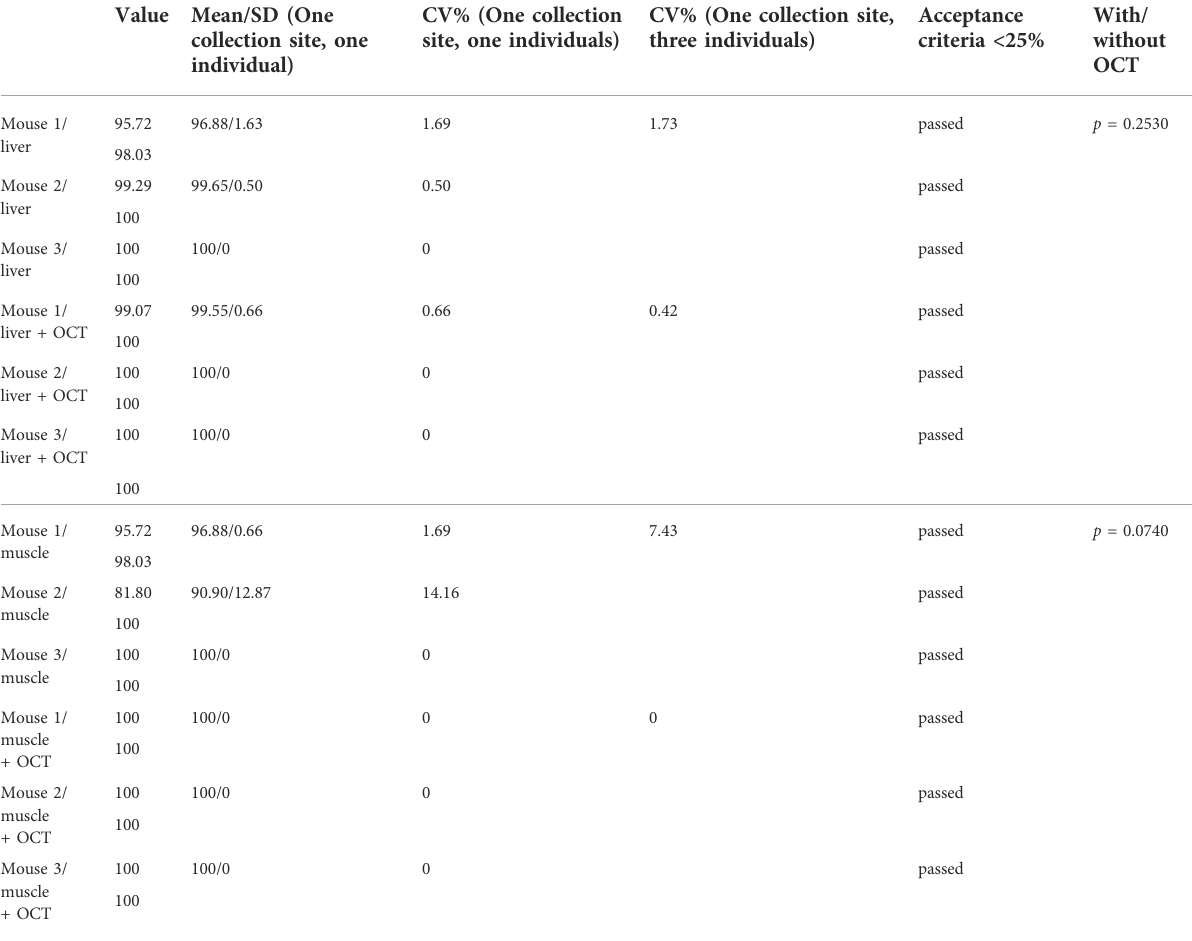
TABLE 3 Reproducibility and Robustness: Assessment of morphological evaluability of liver and muscle samples direct frozen in liquid nitrogen. Value Mean/SD (One collection site,